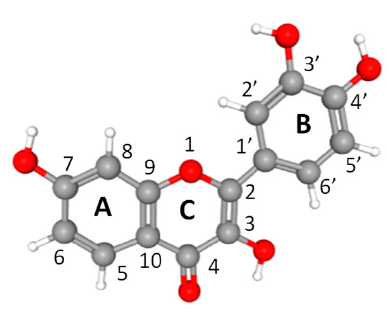
Figure 1. Ball-and-stick model and atom numbering of fisetin. Atoms are colored according to their type: oxygen, red; carbon, gray; hydrogen, white.